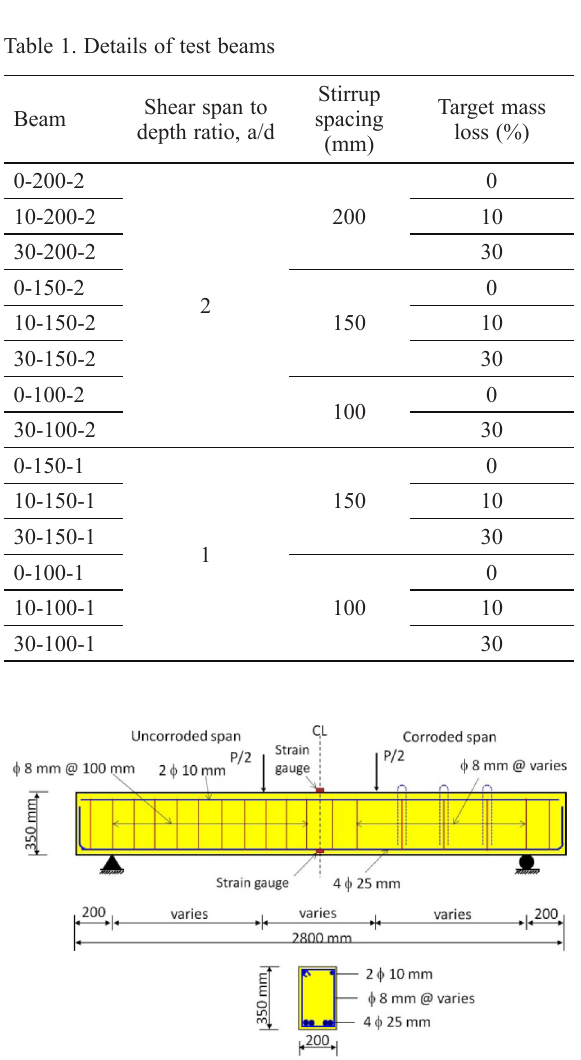
Fig. 1. Typical beam reinforcement and